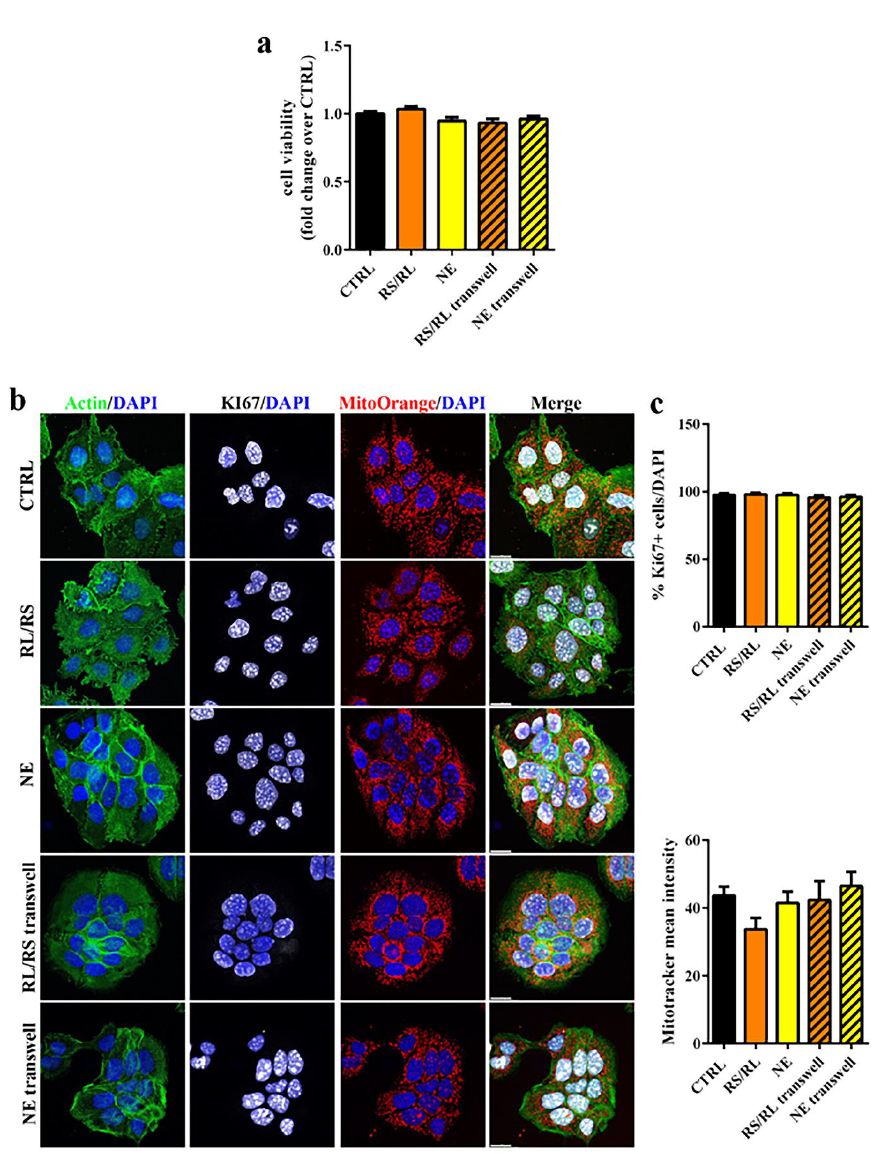
Figure 4. Cytotoxicity evaluation of Eudragit ® RS/RL- and Eudragit ® NE-coated specimens at 24 h of incubation. ( a ) Cell viability of HT1376 cells exposed to different samples for 24 h ( n = 6). Untreated cells (CTRL) were used as negative control; ( b ) confocal microscope images of HT1376 cells stained with phalloidin to detect actin (green), Ki67 (white), Mitotracker Orange (red) and DAPI (blue) (20 µm scale bar); ( c ) upper panel: graph of the % of Ki67+ cells over total cells counted by DAPI staining; bottom panel: graph of the mean fluorescent intensity of Mitotracker Orange ( n = 3).